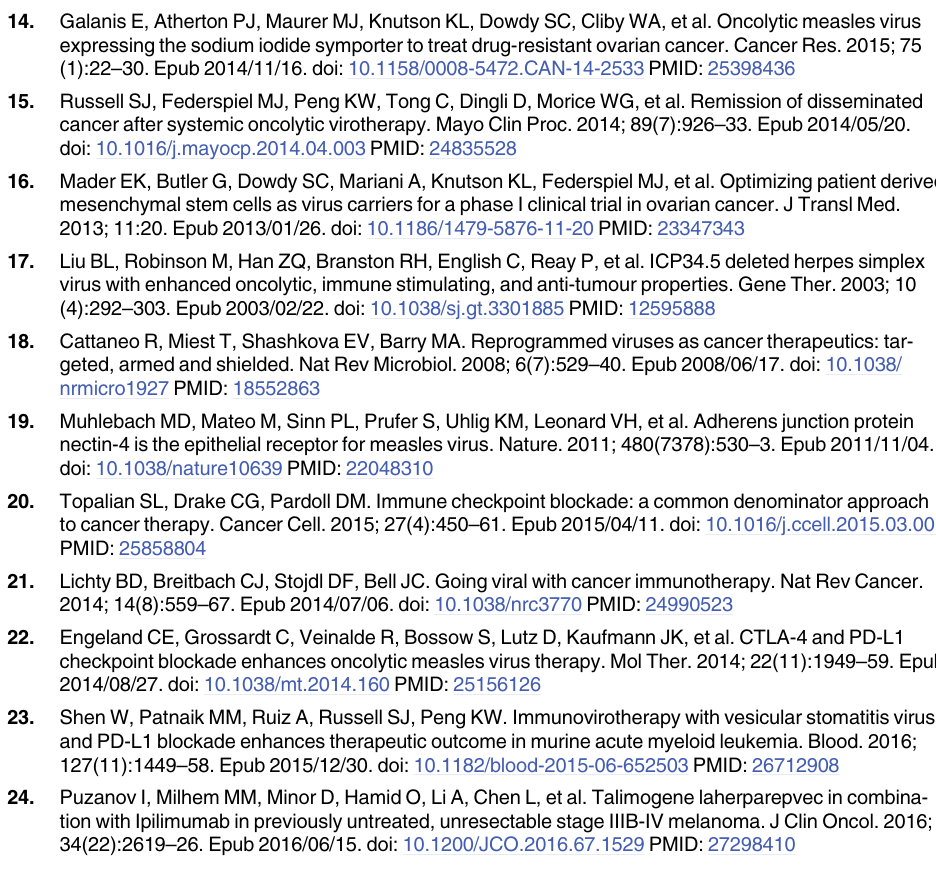
PLOS Pathogens| DOI:10.1371/journal.ppat.1006190 March 16,